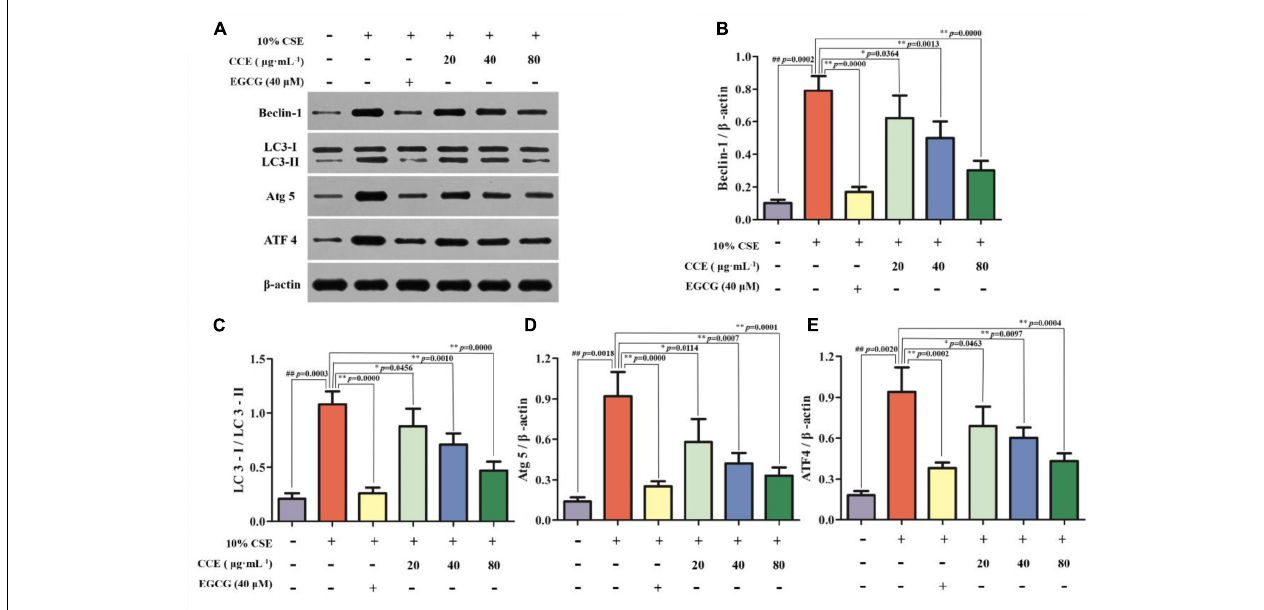
FIGURE 3 | Regulation of CCE on 10%CSE-induced autophagic protein expression levels in NHBE cells. These cells were treated with 10% CSE in the presence or absence of 20, 40, 80 µ g · mL − 1 CCE for 24 h. EGCG of 40 µ M was selected as positive control. Western blotting analysis (A) was performed for the visualization of autophagic proteins including Beclin-1 (B) , LC3-II/LC3-I ratio (C) , Atg5 (D) and ATF4 (E) . Data are expressed as means ± SD ( n = 3). ## p < 0.01, vs. the blank control; ∗ p < 0.05, ∗∗ p < 0.01, vs. 10%CSE.